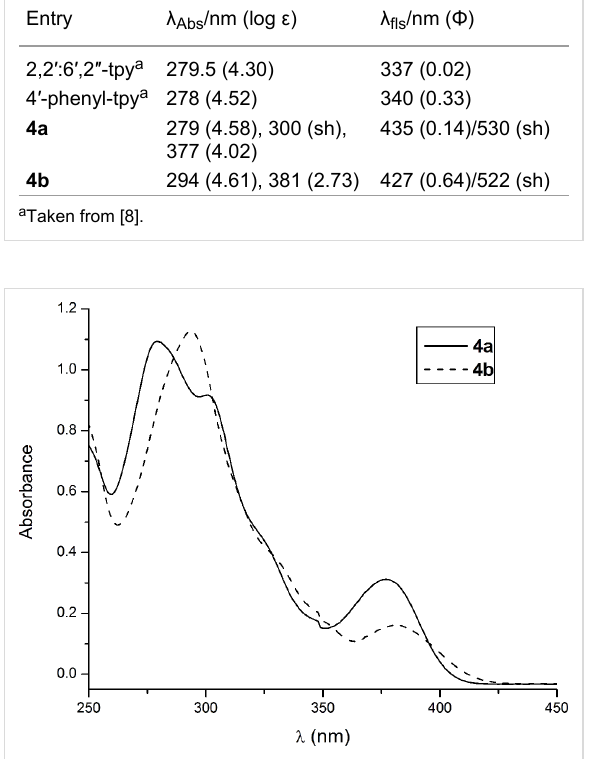
Figure 4: Absorption spectra of the azulene-containing terpyridine, 4a and 4b in CH 2 Cl 2 solution at room temperature.